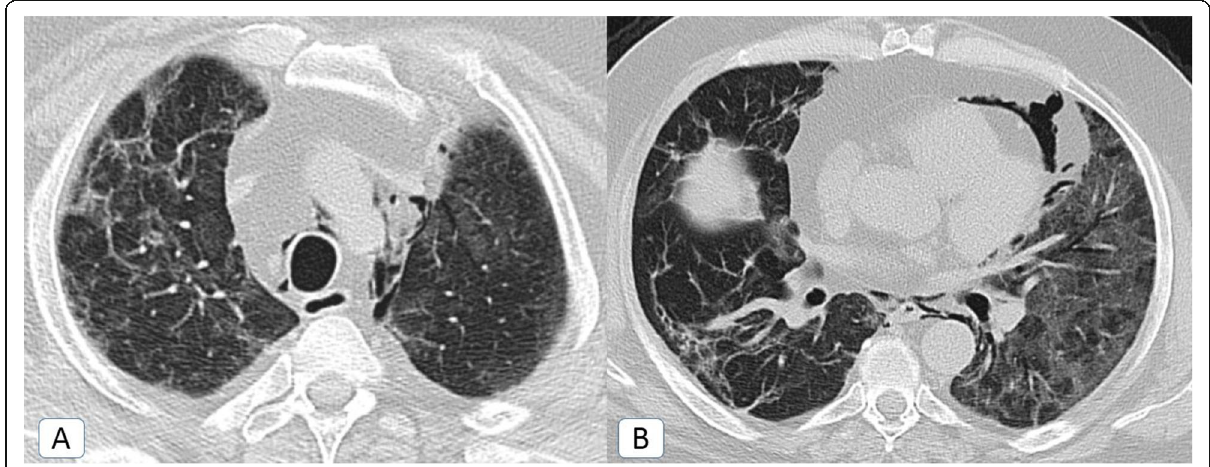
Fig. 4 COVID-19 infection complicated by spontaneous pneumo-mediastinum: a 44-year-old male COVID-19 patient. A , B Axial chest CT (lung window) revealed spontaneous pneumo-mediastinum with bilateral ground-glass patches and fibro-atelectatic bands of COVID-19 infection. Minimal associated pneumo-thorax was also